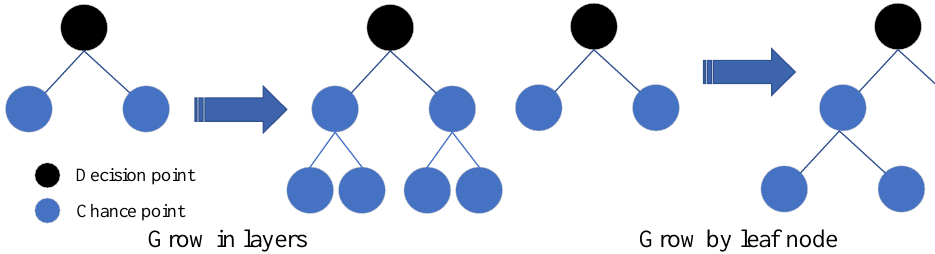
Figure 1. Schematic diagram of decision tree growth strategy.